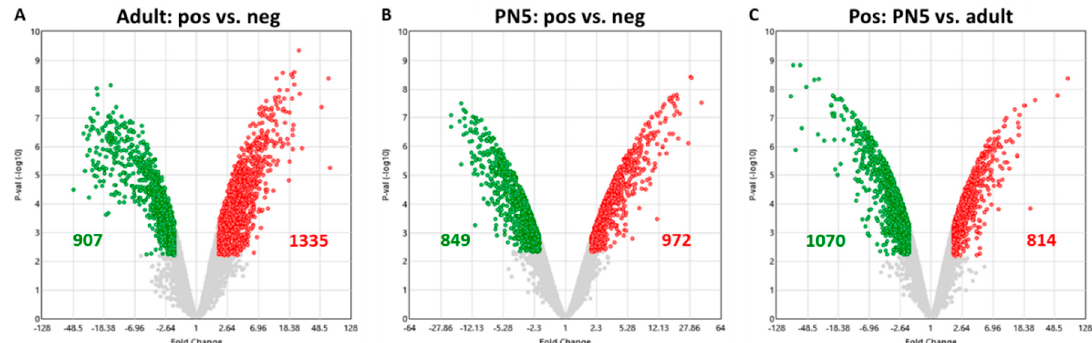
Figure 1. Volcano plots of the up- and downregulated DEG in ( A ) adult Lgr5 + compared to adult Lgr5 − , ( B ) PN5 Lgr5 + compared to PN5 Lgr5 − and ( C ) PN5 Lgr5 + compared to adult Lgr5 + . The horizontal axis is fold change ≥ 2 or ≤ − 2, and the vertical axis represents the p -value after the negative logarithm conversion. The red dots indicate the upregulated genes, whereas the green dots represent the downregulated genes. The corrected p < 0.05 was an absolute threshold used to select DEGs. DEGs, differentially expressed genes.